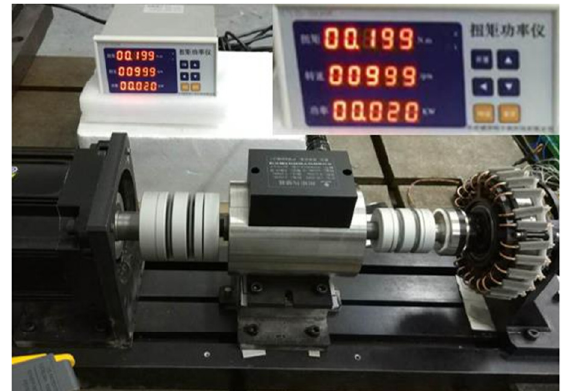
Figure 12. Motor power and torque test.